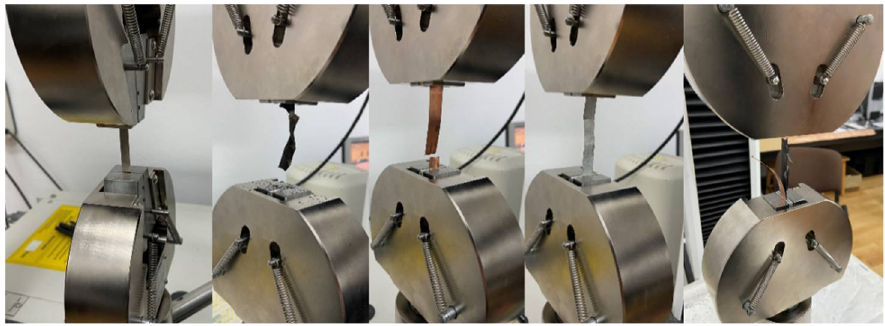
Figure 1. Tensile test of battery materials as individual or sandwich samples.